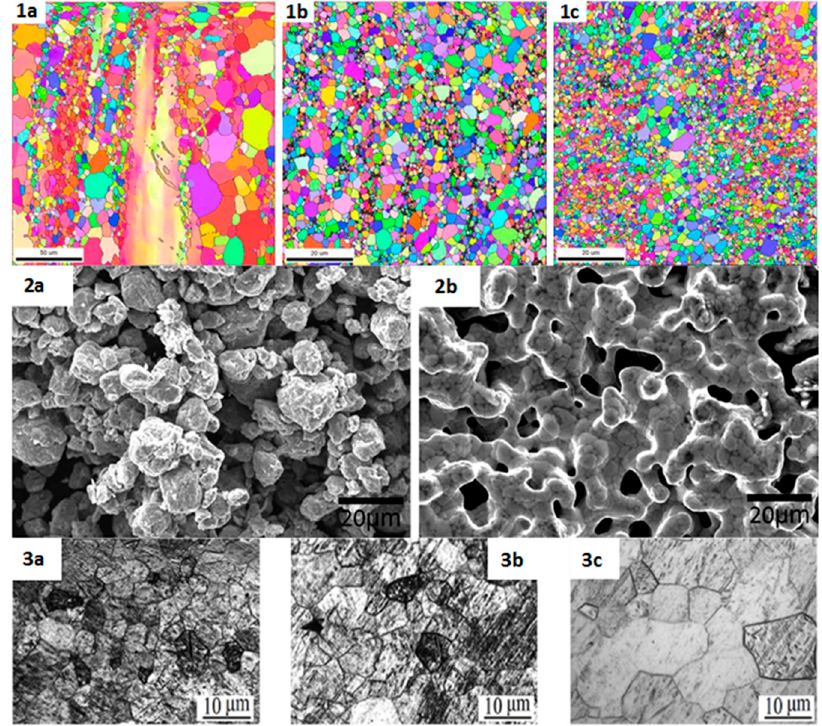
Figure 11. Grain structures or morphologies of magnesium alloy (AZ31) (series 1), iron alloy (Fe-Mn-1Ca) (series 2) and commercially pure (CP) titanium (series 3). Series 1 depicts the cyclic extrusion compression (CEC) process of AZ31 at 300 °C, ( 1a ) showing the alloy “as extruded’, ( 1b ) showing the alloy after 7 passes and ( 1c ) showing the alloy after 15 passes. Series 2 shows the morphology of the iron based alloy before ( 2a ) and after ( 2b ) the binder-jet-3D printing process has been completed. Series 3 shows the morphology of a CP titanium sample after 3 laser shock peening impacts. ( 3a ) shows the morphology of the sample close to the surface, while ( 3b ) shows the morphology of the sample less than 0.5 mm below the surface and ( 3c ) shows the sample morphology at about 2 mm below the surface. All images—series 1, 2 & 3—were reproduced with permission from [166], [4] and [3], respectively.